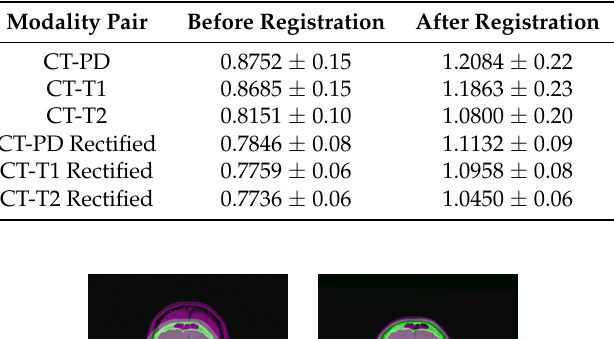
Table 1. Mean and standard deviation of mutual information computed for each pair of the CT-MR scan before and after registration using the proposed idea. Details can be found in the main text.